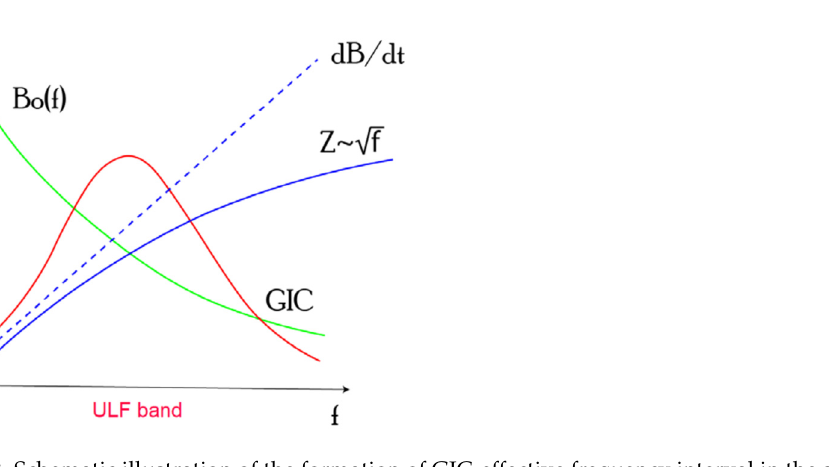
Figure 8. Schematic illustration of the formation of GIC-effective frequency interval in the spectral content of geomagnetic variations.